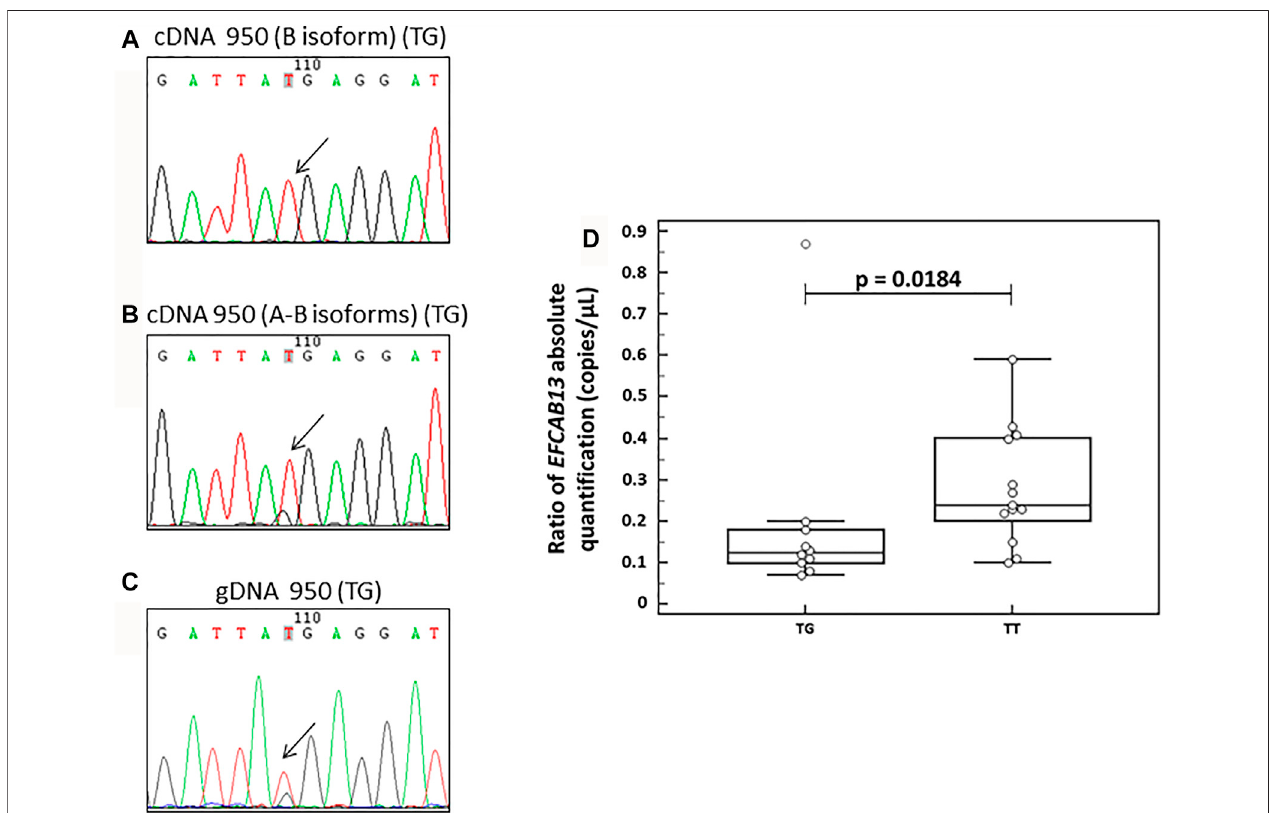
FIGURE 3 | Analysis of the EFCAB13 transcript . (A – C) Electropherograms derived from Sanger sequencing on a heterozygous healthy subject for the variant rs118004742.( A) SequencederivedfromRT-PCRdesignedtoamplifycDNAofonlyisoformBofthe EFCAB13 transcript; (B) sequencederivedfromRT-PCRdesigned to amplify cDNA of both A and B EFCAB13 transcripts; (C) sequence derived from PCR on genomic DNA of the same subject. The rs118004742 variant is indicated by anarrow. (D ) EFCAB13 cDN A expression levelsbyddPCR analysis.Boxplotsdisplaytheexpression levelsbyddPCR analysisin23subjects,including10carriers (TG) and 13 non-carriers (TT) of the stop-gain rs118004742-G variant. The ddPCR assay tests the expression of both A and B EFCAB13 isoforms. The p -value was derived from the Mann – Whitney